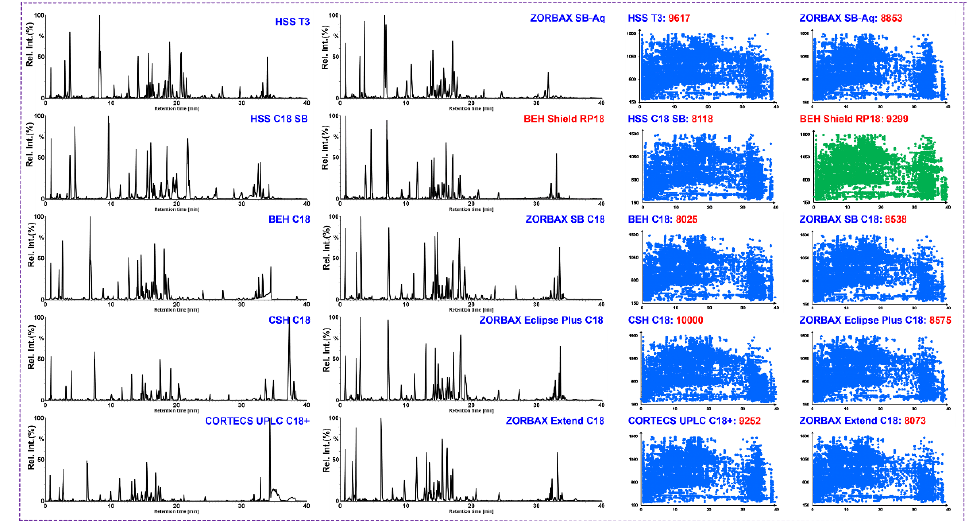
Figure 2. Method development for UHPLC/IM-QTOF-MS by evaluating the separation of ginseno- sides on ten candidate UHPLC columns (left: the base peak chromatograms obtained on ten candi- date columns; right: the two-dimensional scatter plots of the resolved peaks based on the t R and m/z information).